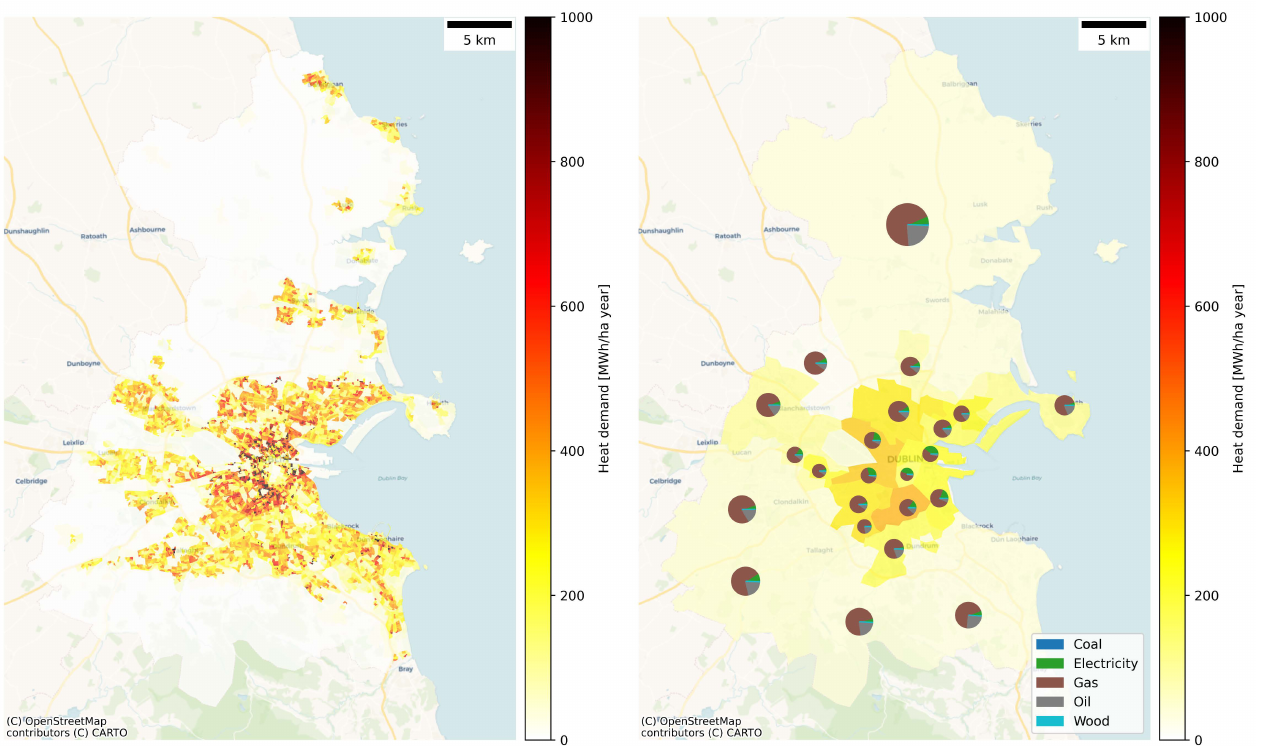
Figure 5. Spatial distribution of the heat demand density per small area ( left ) and energy carrier distribution related to the required heat demand per postcode ( right ) in Dublin.